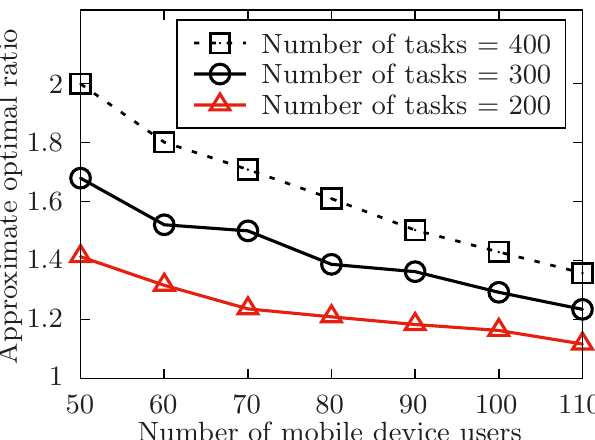
Figure 4. The approximate optimal ratio of the proposed algorithm vs. different n when m = 200,300,400.